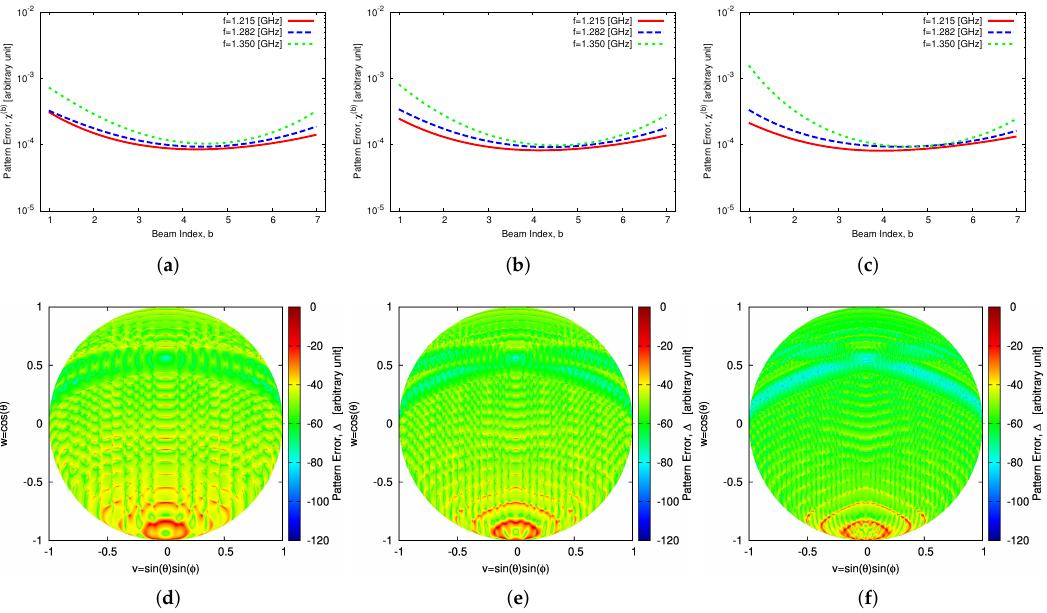
Figure 11. Numerical Assessment (Sparse CPA, M = 16, d = λ , B = 7)—Plot of ( a , c , e ) the pattern 2 matching error, χ ( b ) , versus the beam index, b ( b = 1, . . ., B ), and of ( b , d , f ) the local mismatch index, ∆ , in the ( v , w )-plane for the b = 1 beam at f max = 1.350 GHz in correspondence with the CPA configurations with vertical sector width equal to ( a , b ) ψ = 30 ◦ , ( c , d ) ψ = 60 ◦ , and ( e , f ) ψ = 90 ◦ .